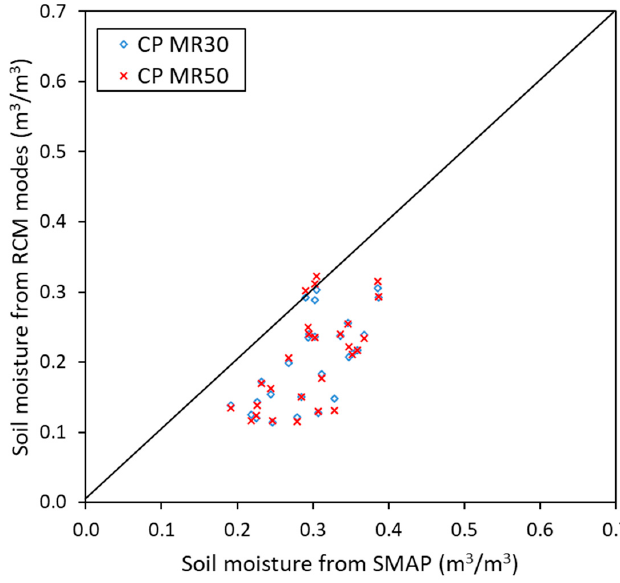
Figure 11. Comparison between retrieved soil moisture values from RCM CP and SMAP.